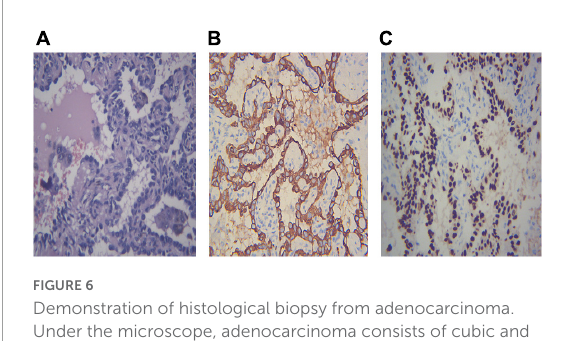
FIGURE6 Demonstration of histological biopsy from adenocarcinoma. Under the microscope, adenocarcinoma consists of cubic and columnar cells with large or irregular nuclear nuclei and distinct nucleoli ( A , HE 400 × ). Tumor cells show positive immunoreactivity for cytokeratin 7 and TTF-1 ( B,C IHC 400 × ).